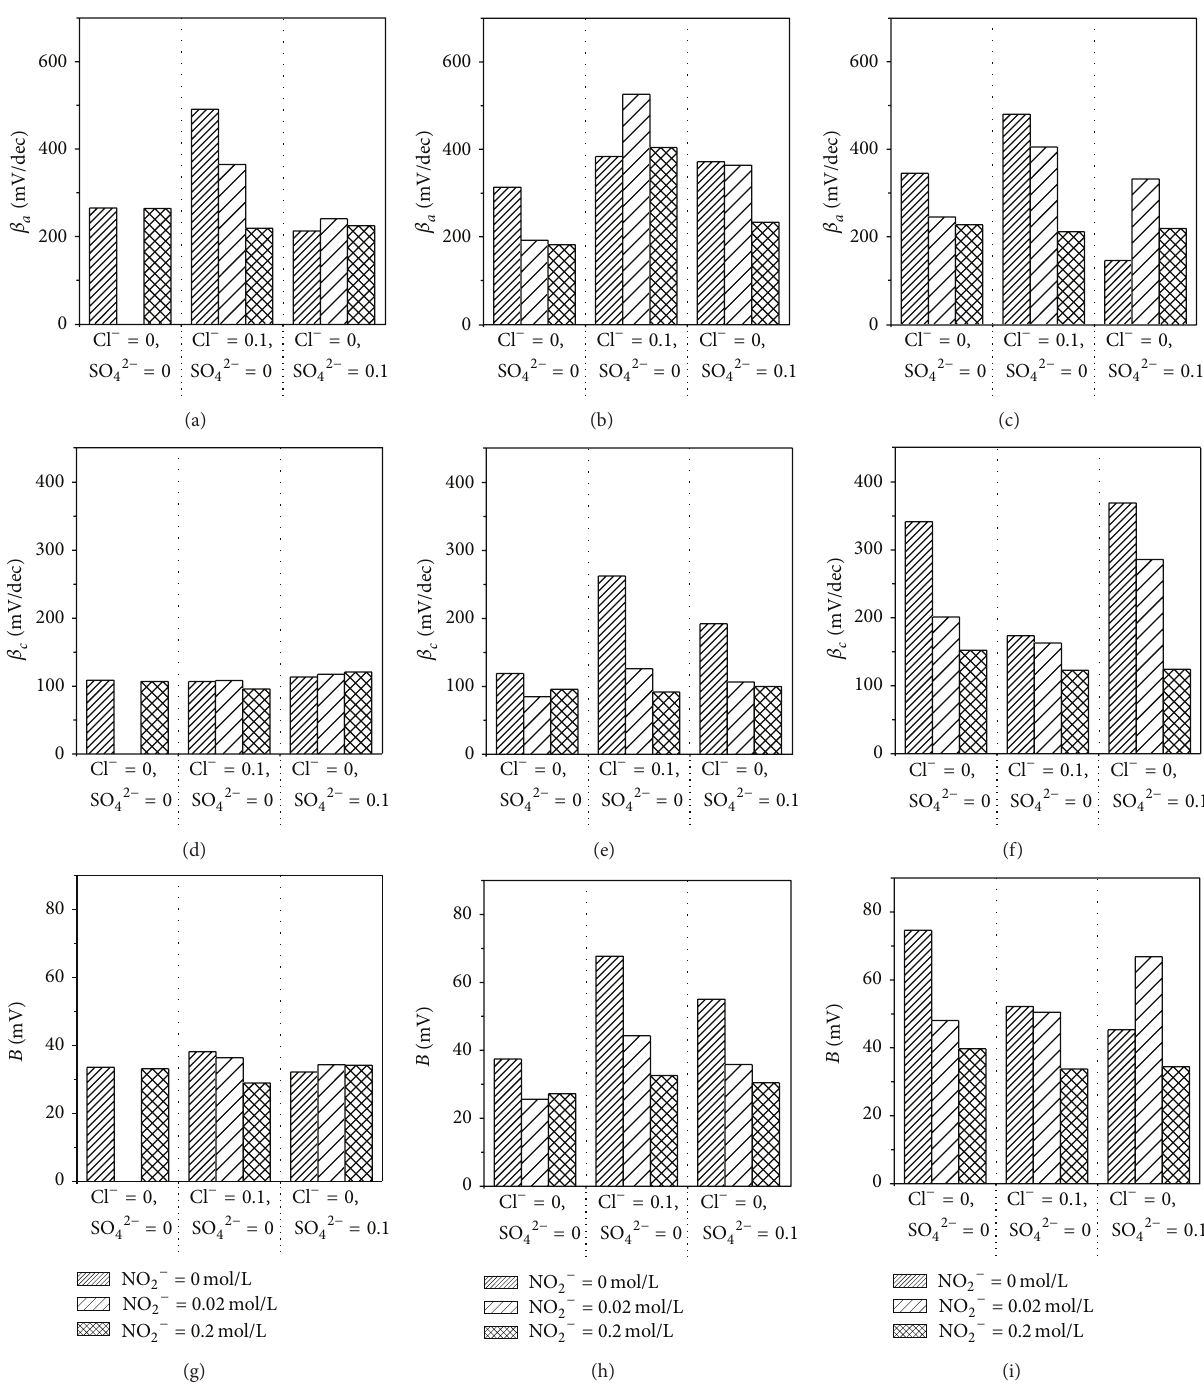
10 −7 A/cm 2 for 0.2 mol/L nitrite. On the other hand, the passivity breakdown potential was observed and increased with the increasing of nitrite concentration. It was 125 mV for 0.02 mol/L nitrite and 225 mV for 0.2 mol/L nitrite. Besides this, Tafel slopes 𝛽 𝑎 and 𝛽 𝑐 and Stern-Geary constant 𝐵 were greatly influenced by the nitrite concentration. The value of 𝛽 𝑐